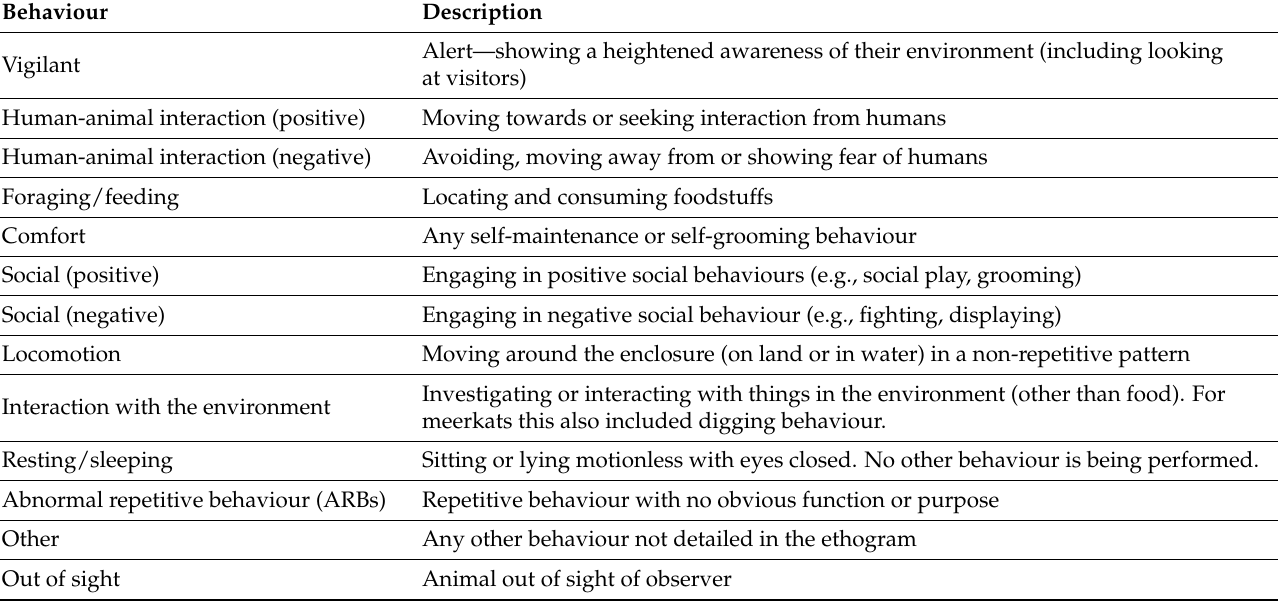
Table 2. Ethogram of behaviours for study animals during the study period